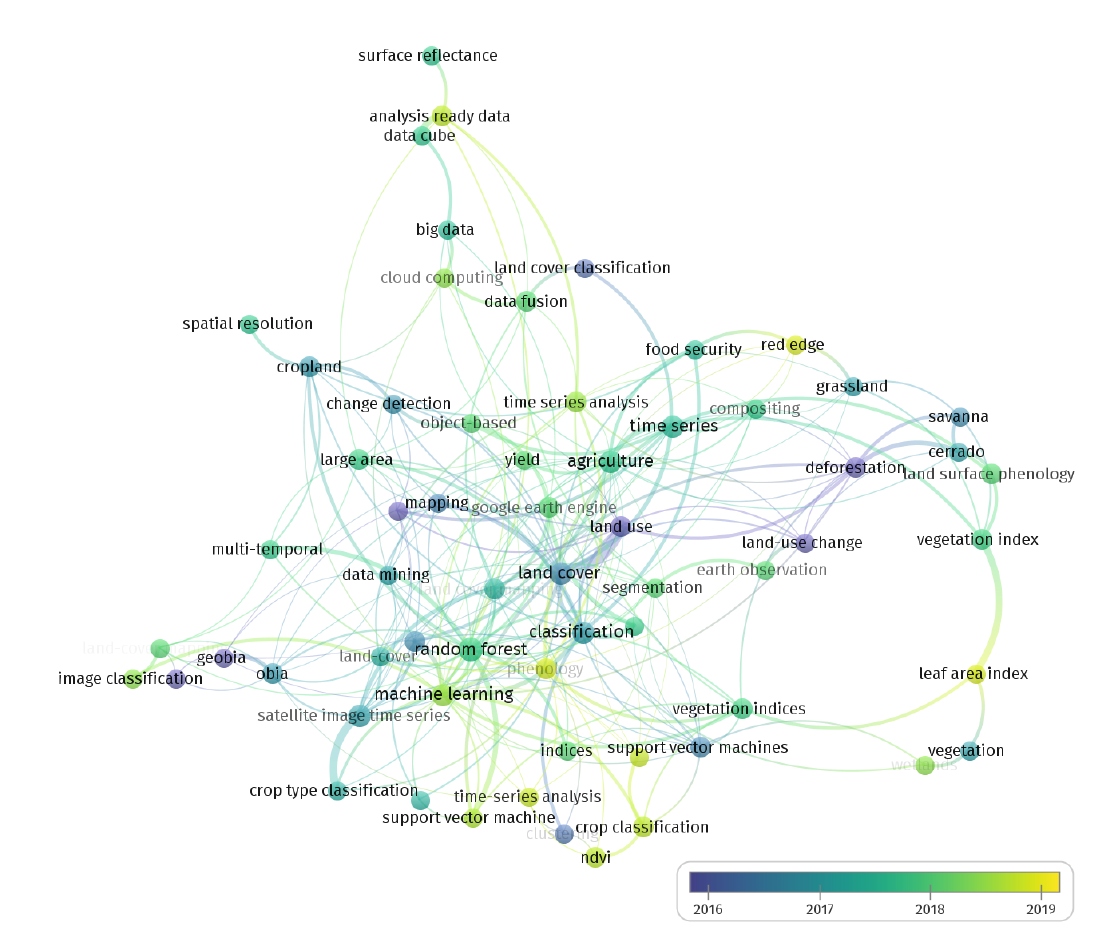
Figure 5. Scientific network mapping of the papers’ keywords. Colors indicate the year in which each keyword was more used. Lines represent co-occurrence link strength among